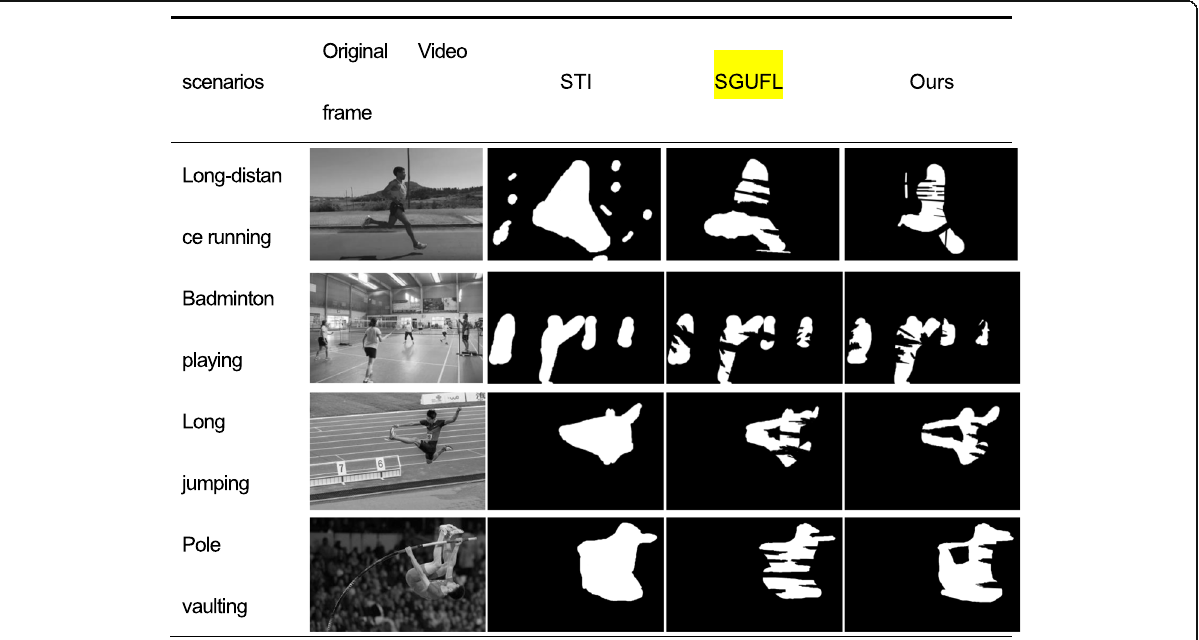
Fig. 9 Comparison of different video simulation